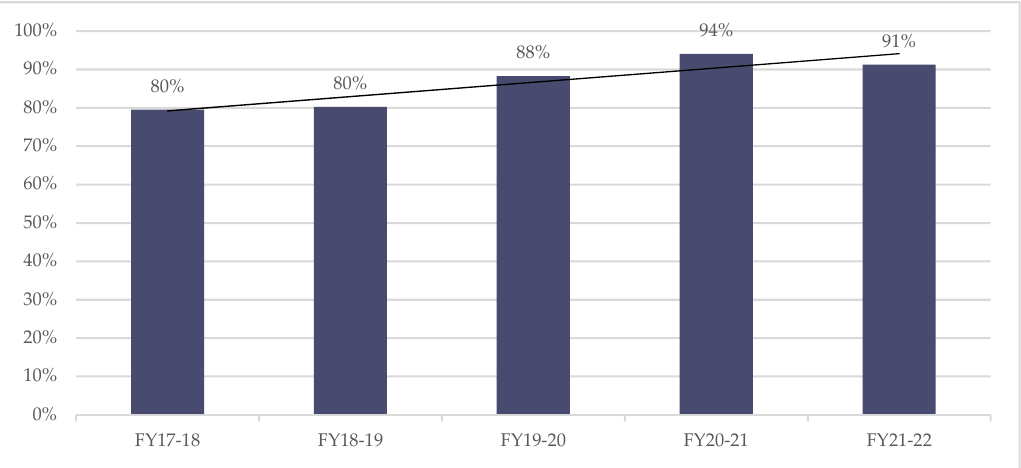
( c ) Figure 1. Goal planning participation: ( a ) Annual inpatient attendance at goal planning meetings; ( b ) Annual family attendance at goal planning meetings; ( c ) Annual MDT attendance at goal plan- ning meetings. * Clinical psychology attendance was calculated only for goal planning meetings where psy- chology was Keyworking. 3.1.2. Frequency of Goal Planning Meetings The original programme design aimed for a meeting every 2–3 weeks, so 3 weeks was the standard set at the commencement of the QIP. However, this was amended to within 4 weeks in 2018 to align with the guidance issued as part of the NHS England Peer